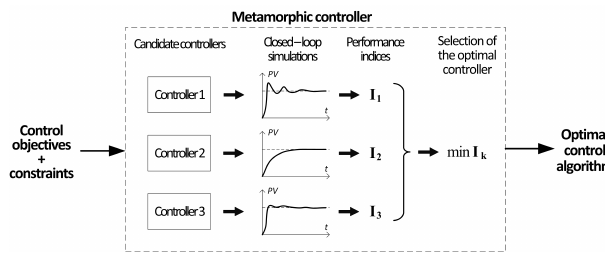
Figure 3: The idea of the metamorphic controller as the tool supporting control engineers.